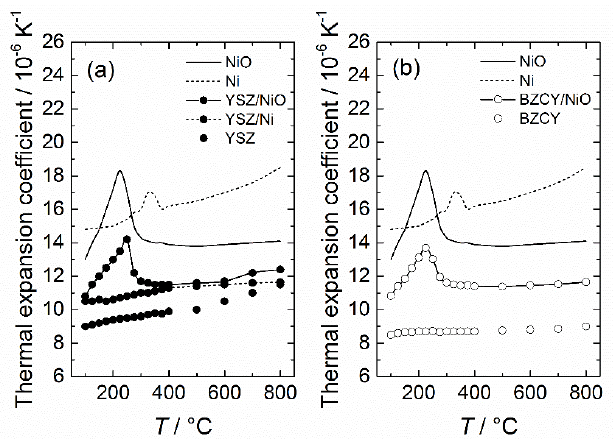
Figure 10. Thermal expansion coefficients (α) of ( a ) NiO, YSZ, YSZ/NiO with 52 vol% NiO, Ni and YSZ/Ni with 40 vol% Ni [131] and ( b ) NiO, BZCY72 (from Figure 4b), BZCY72/NiO with 52 vol% NiO and Ni. Note that the thermal expansion coefficient for the cermet BZCY72/Ni is not included as described in the text.